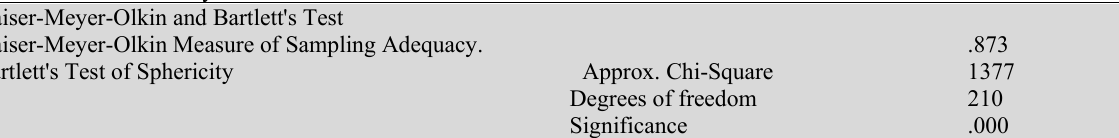
Test results of Kaiser-Meyer-Olkin and Barlett’s Kaiser-Meyer-Olkin and Bartlett's